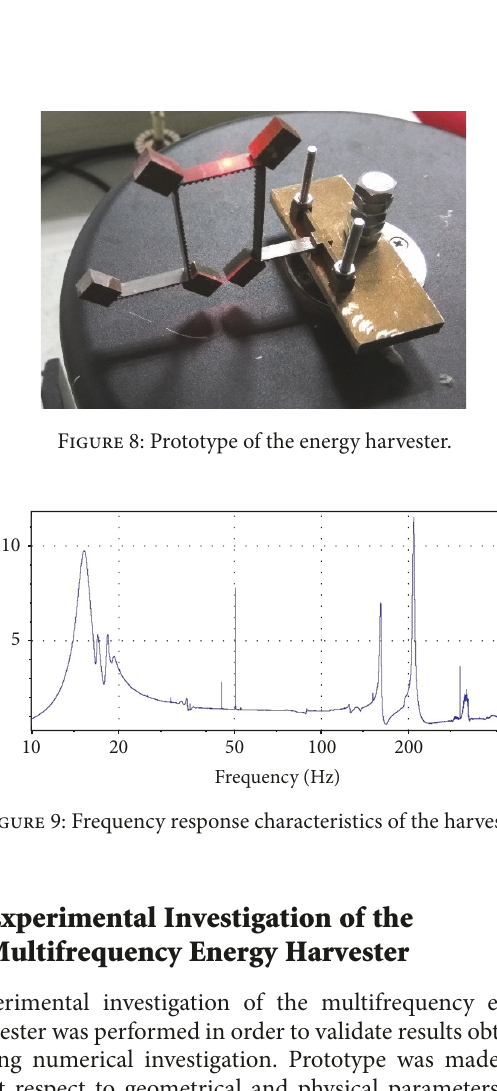
Figure 7: Comparison of electrical characteristics.